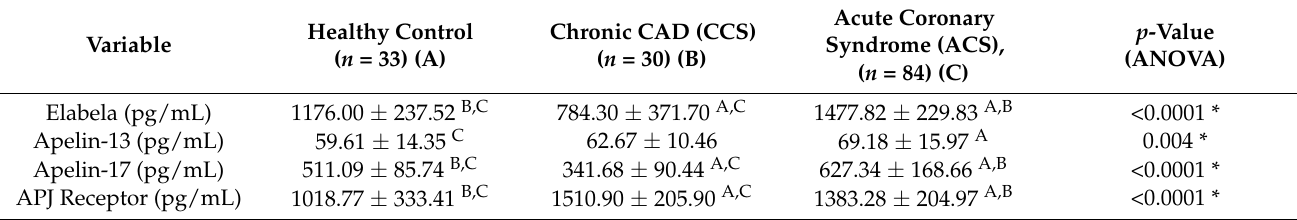
Table 3. Concentration of plasma ELA, AP-13, AP-17 and APJ receptor levels in CCS and ACS groups and in healthy controls. Descriptive data are presented as mean ( ± SD).